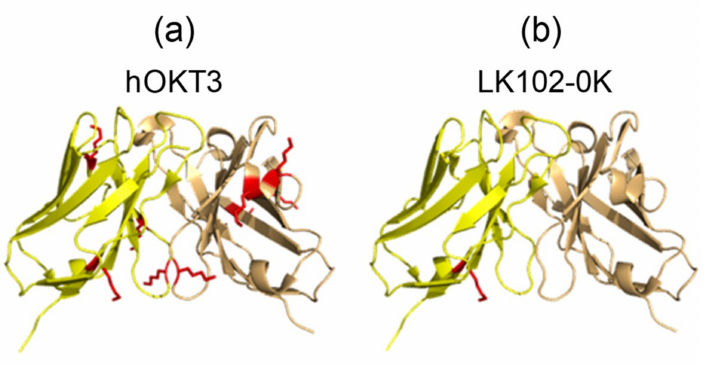
Figure 3. Lysine positions on ( a ) hOKT3 scFv and ( b ) LK102-0K scFv where all lysines were mutated except for LK102. Yellow-colored and wheat-colored domains are VL and VH domains, respectively, and red-colored residues are lysine. The code of the used crystal structure is